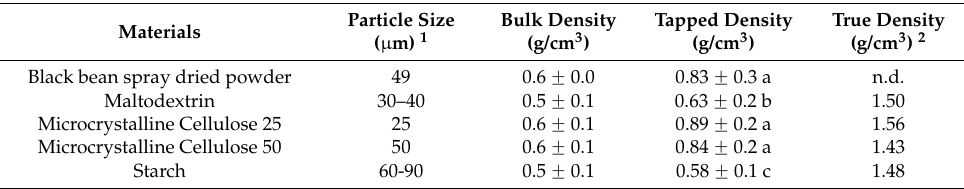
Table 3. Physical properties of different materials